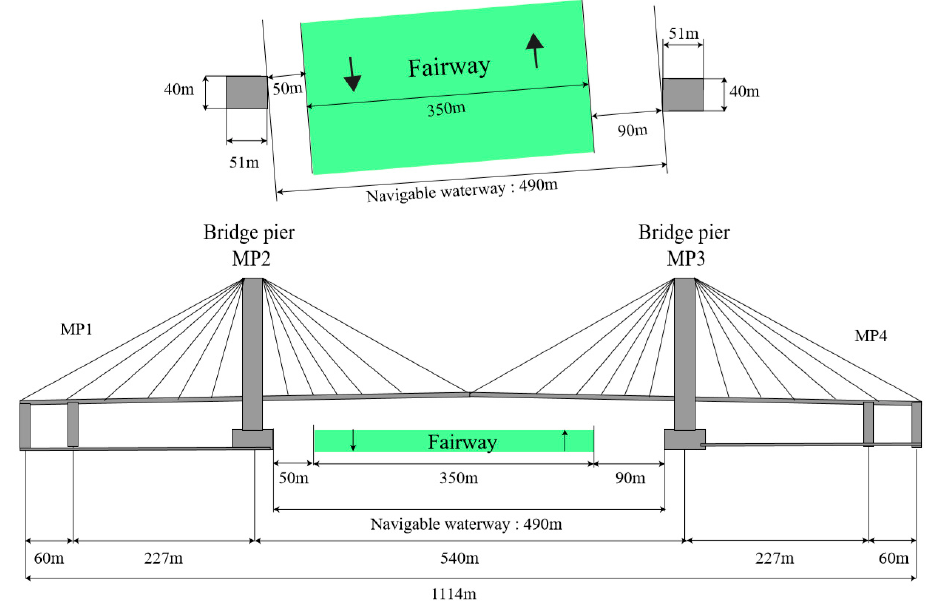
Figure 7. Cable-stayed part of Busan harbor bridge.